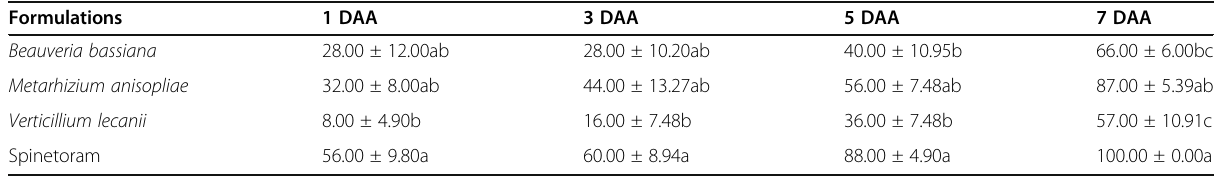
Table 2 Mortality rates (%) resulting from the application of different bioinsecticides against the Tuta absoluta larvae Formulations 1 DAA Beauveria